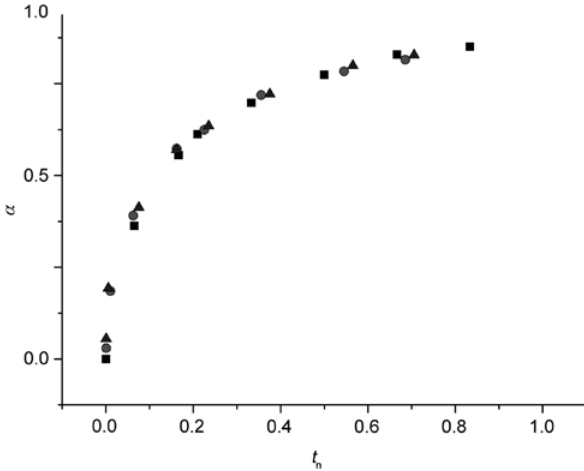
Figure 6: Experimental normalized conversion curves of the caffeine extraction under microwave heating at 40 ° C ( ), 55 ° C ( ) and 60 ° C ( ).